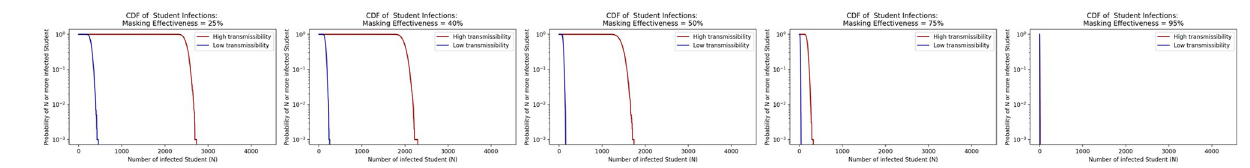
Fig 14. Sensitivity of model to mask effectiveness